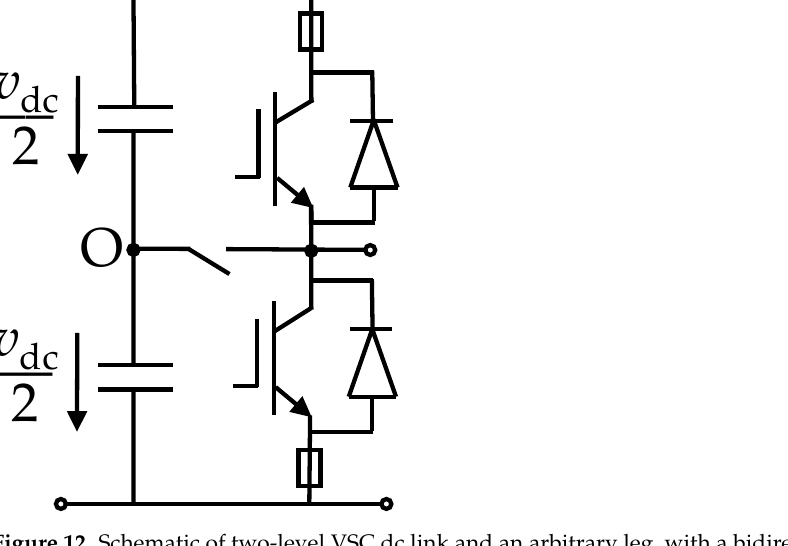
Figure 12. Schematic of two-level VSC dc link and an arbitrary leg, with a bidirectional switch S to connect to the dc-link midpoint O and a fuse in series with each IGBT